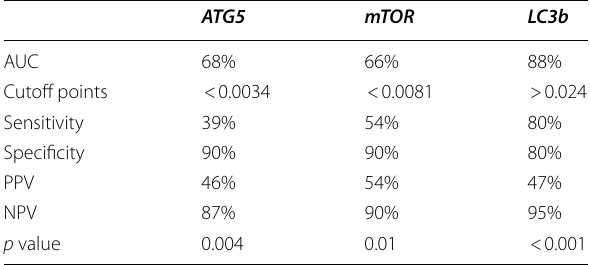
F General linear model with stepwise elimination, P p value and p considered significant if p < 0.05 Table 5 Correlation between autophagy markers and BD